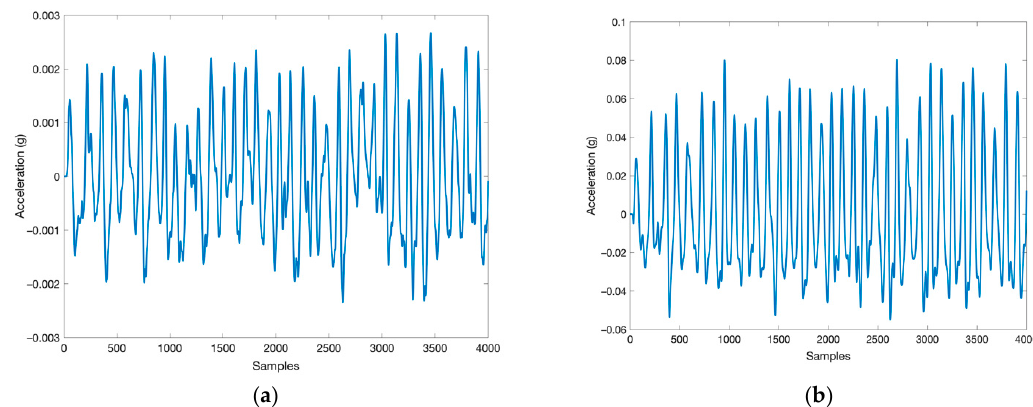
Figure 19. Acceleration close to burst altitude: ( a ) along x , ( b ) along z . Note the different vertical scale. The sampled interval is 274 s.